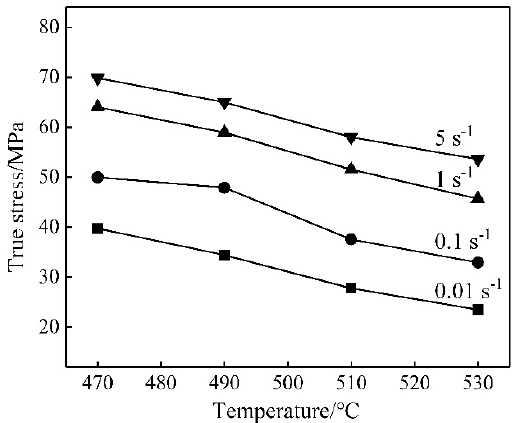
Figure 4. Peak stress of nano-SiCp/Al-Si composites at different conditions.